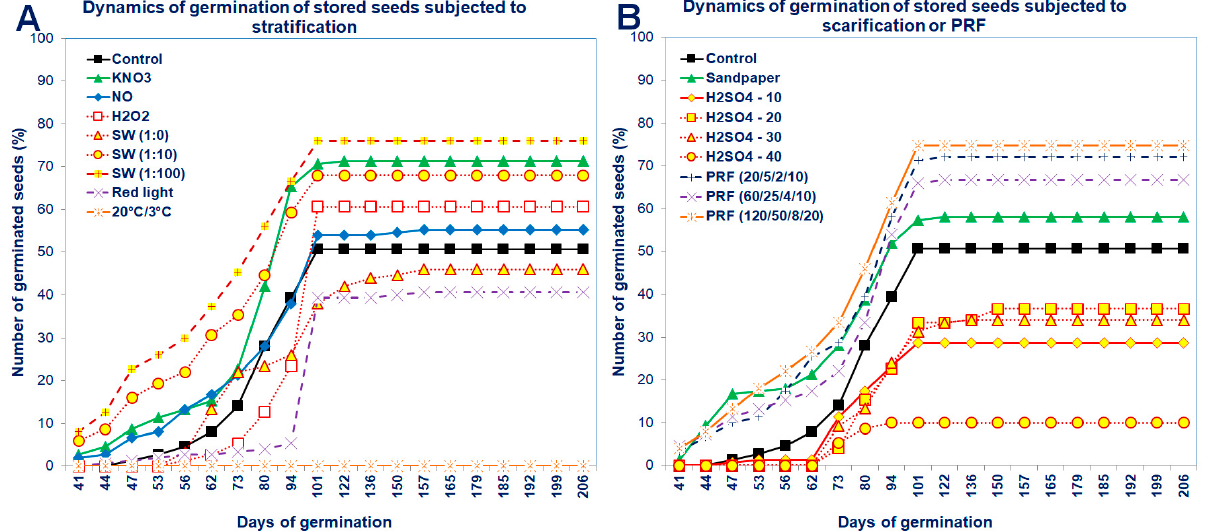
Figure 4. Dynamics of germination of the stored Saskatoon berry seeds subjected to ( A ) stratification (3 °C) in the presence of KNO 3 , NO, H 2 O 2 , smoke-water (SW, in concentrations of 1:1, 1:10, 1:100), or 20 °C/3 °C or ( B ) scarification: sandpaper, sulfuric acid for 10, 20, 30 and 40 min or treatments with red light or with pulsed radio frequency (PRF, 20/5/2/10, 60/25/4/10, 120/50/8/20). Values are the means of three replications of 50 seeds.